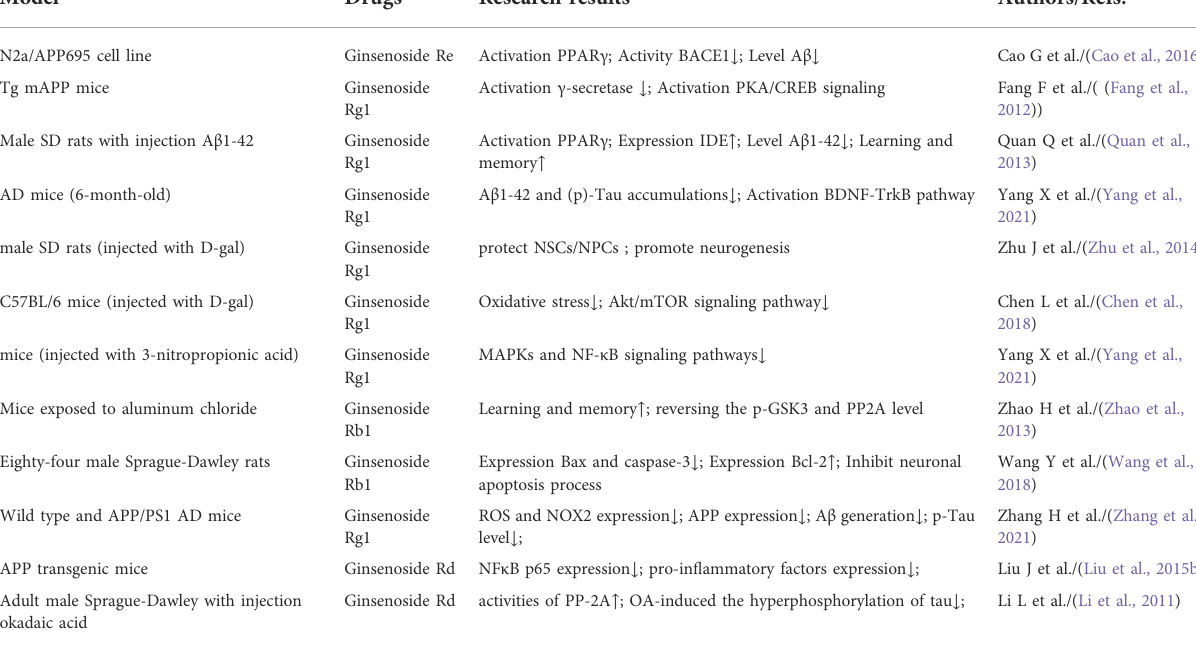
TABLE 1 Effect of ginsenosides on the pathogenesis of AD.